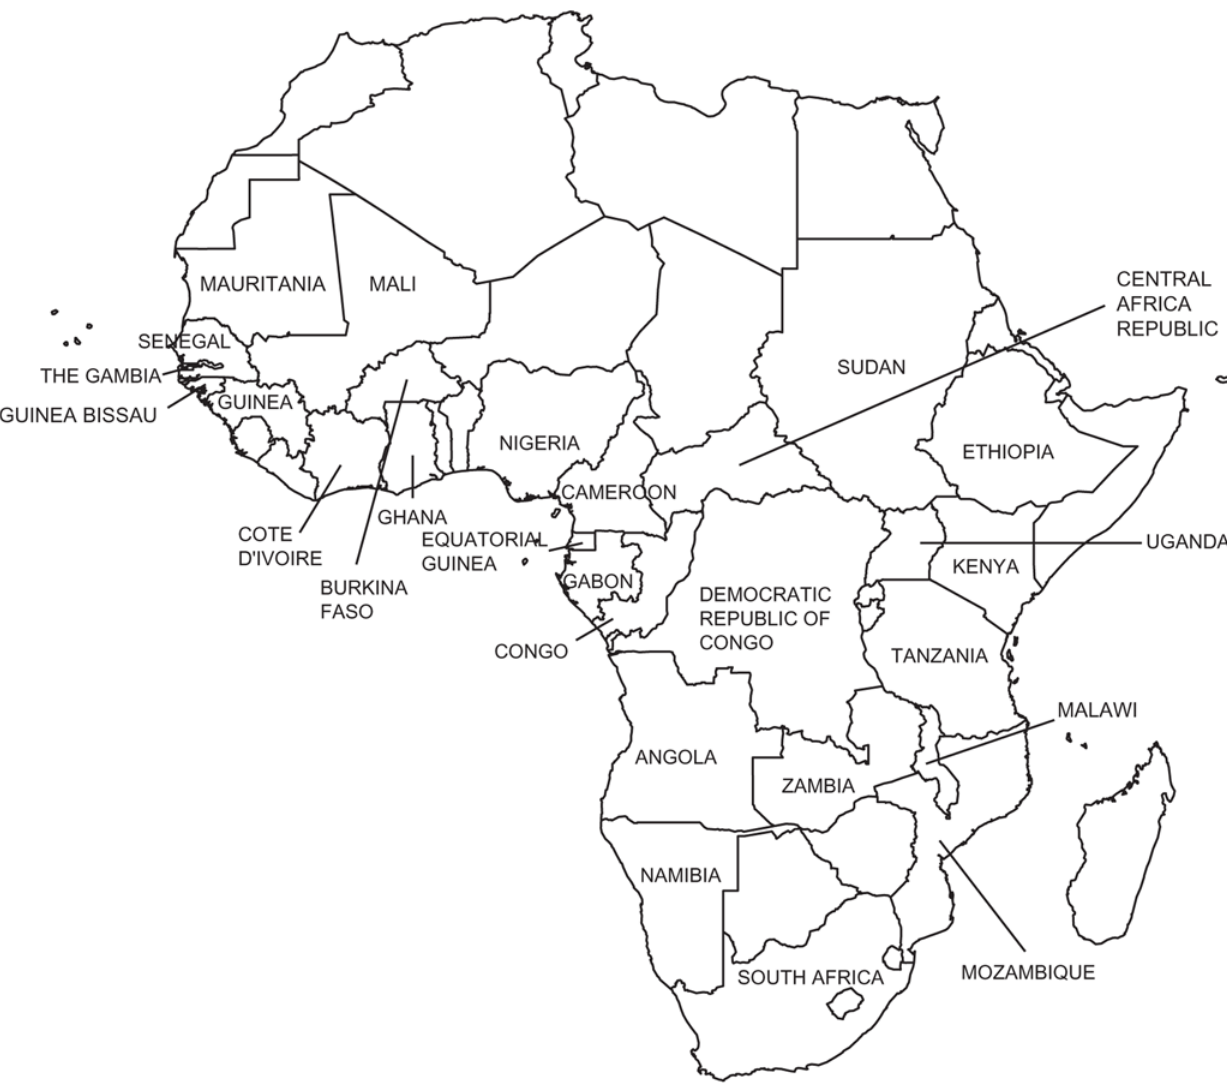
Figure 1. Map of the countries of Africa included in this study.